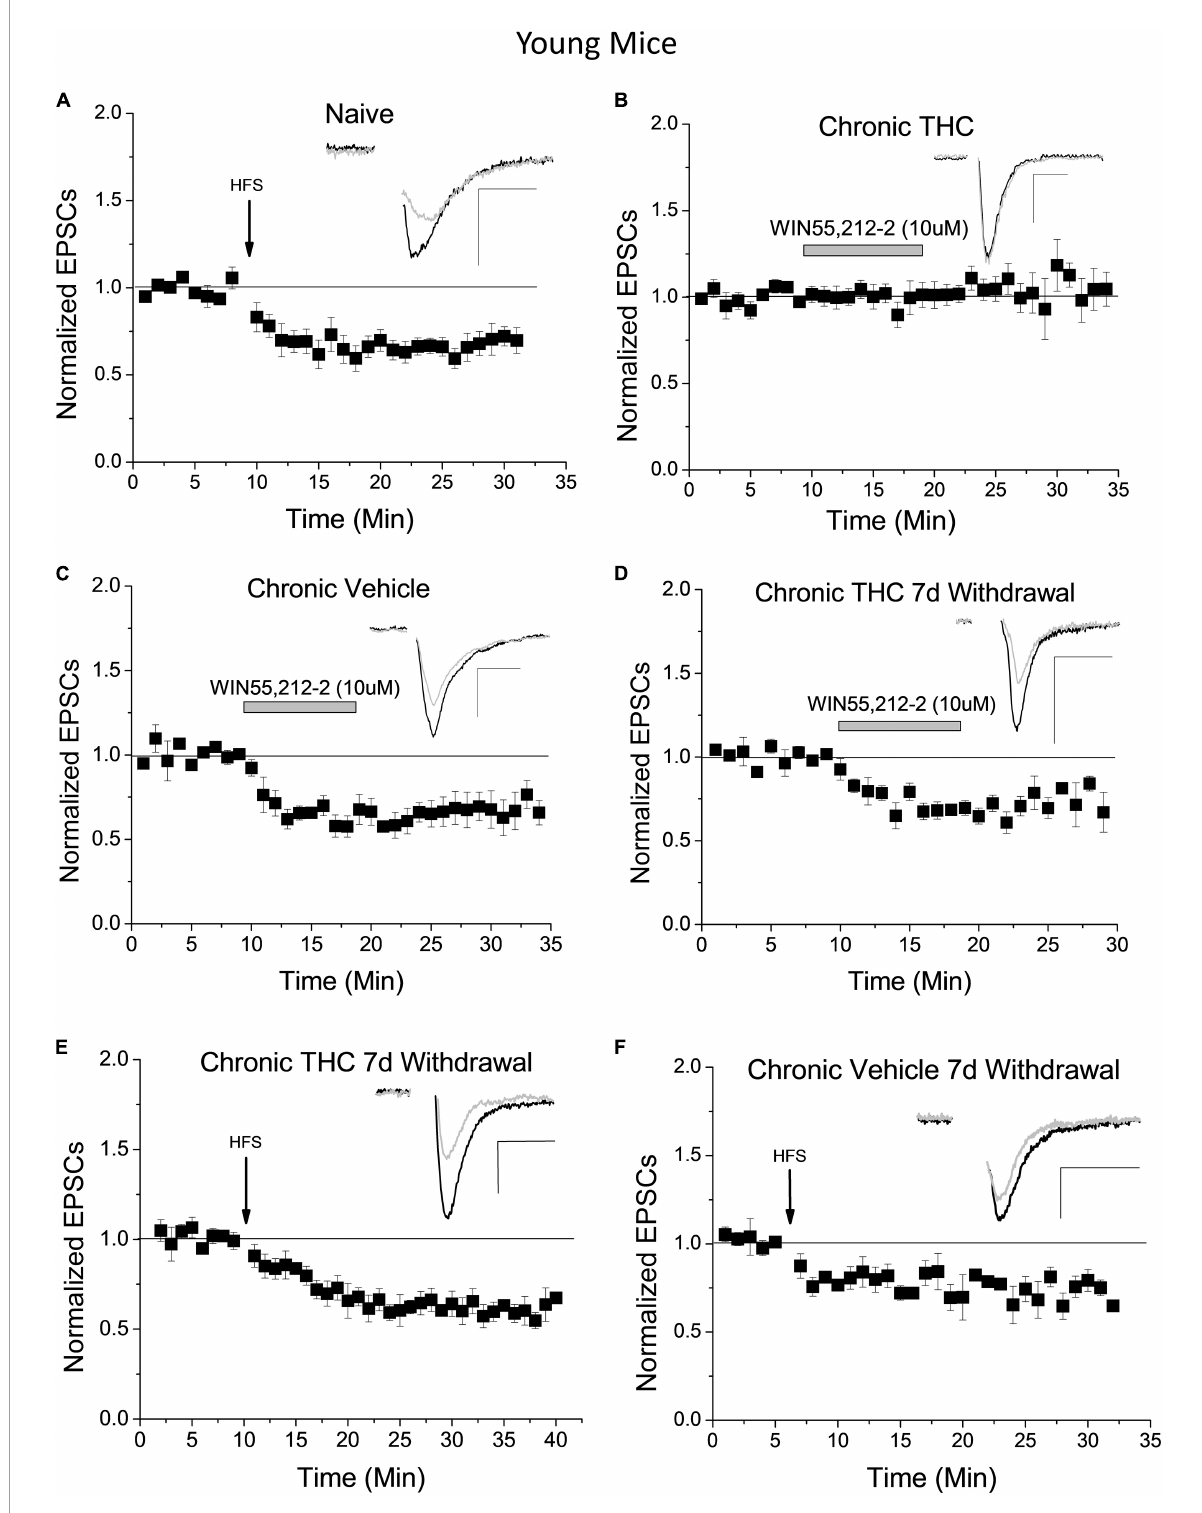
FIGURE1 Chronic THC impact on glutamate inputs and plasticity of VTA GABA neurons. (A) Within naïve young mice (P15-40) a high frequency stimulus (HFS) induces LTD (33 ± 7.1% reduction) 15–20 min post stimulus compared to baseline ( n = 7, p < 0.001), confirming previously reported LTD in mice (Friend et al., 2017). (B) Young mice with chronic (7–10 consecutive days) THC intraperitoneal (IP) injections do not exhibit WIN55,212-2-induce depression compared to baseline ( n = 8, p > 0.1). (C) In contrast, young mice chronically injected with vehicle (0.1%